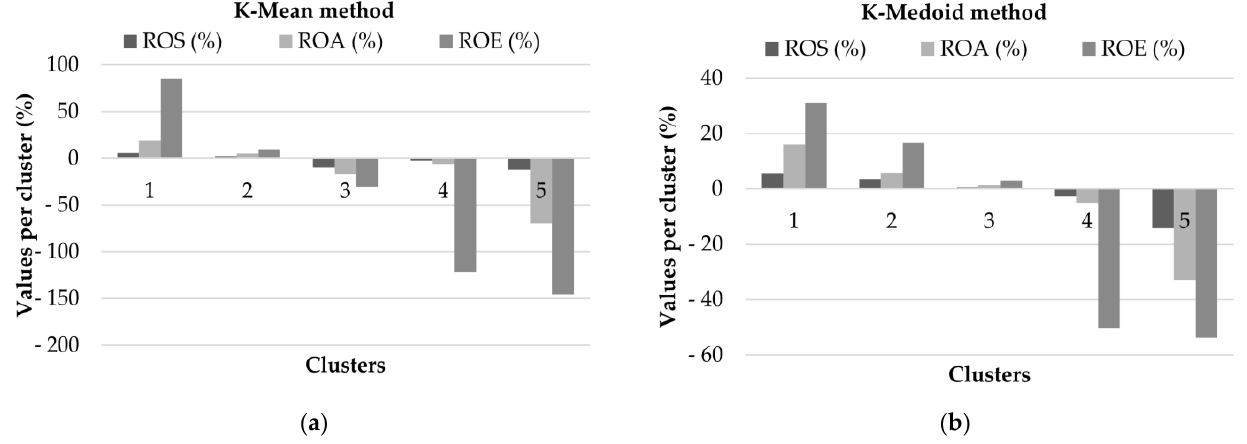
Figure 7. Average financial indicator values per cluster for Hungarian companies: ( a ) K-Mean method; ( b ) K-Medoid method. Source: Authors’ own editing based on own calculations.